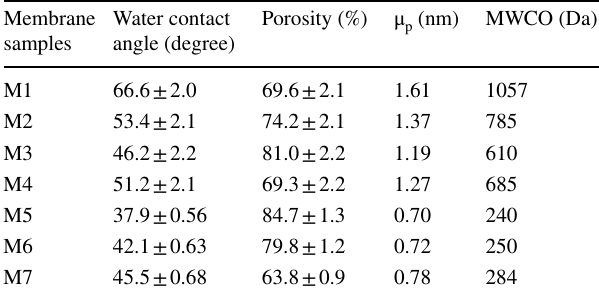
Table 2 Water contact angle, porosity, μ cated membrane Membrane samples